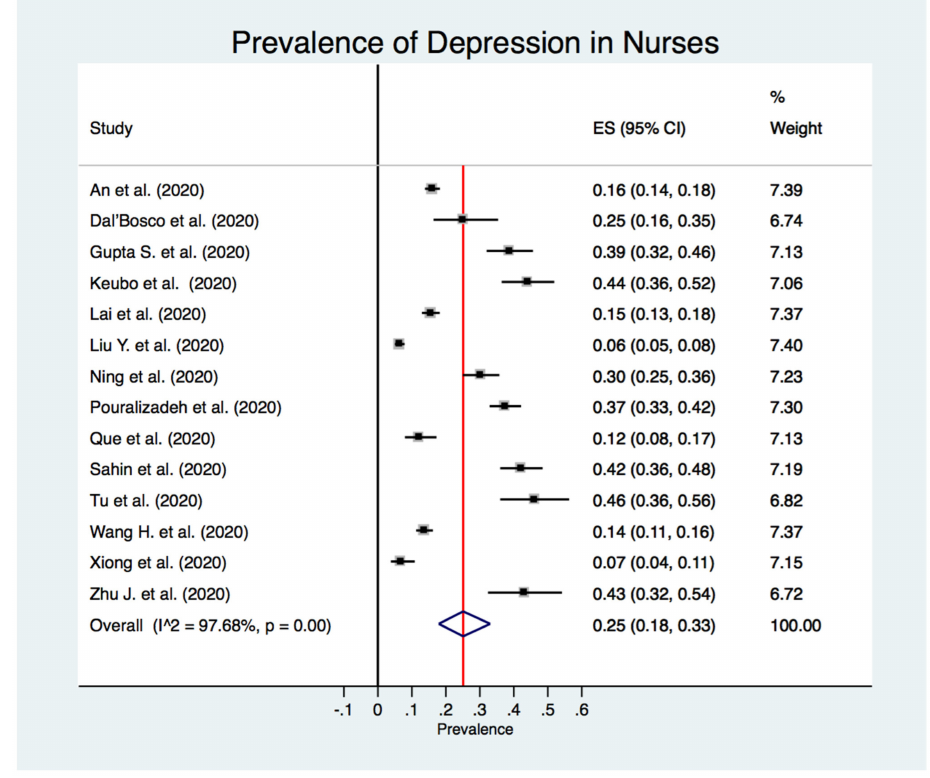
Figure 3. Forest plot for the prevalence of depression among nurses.